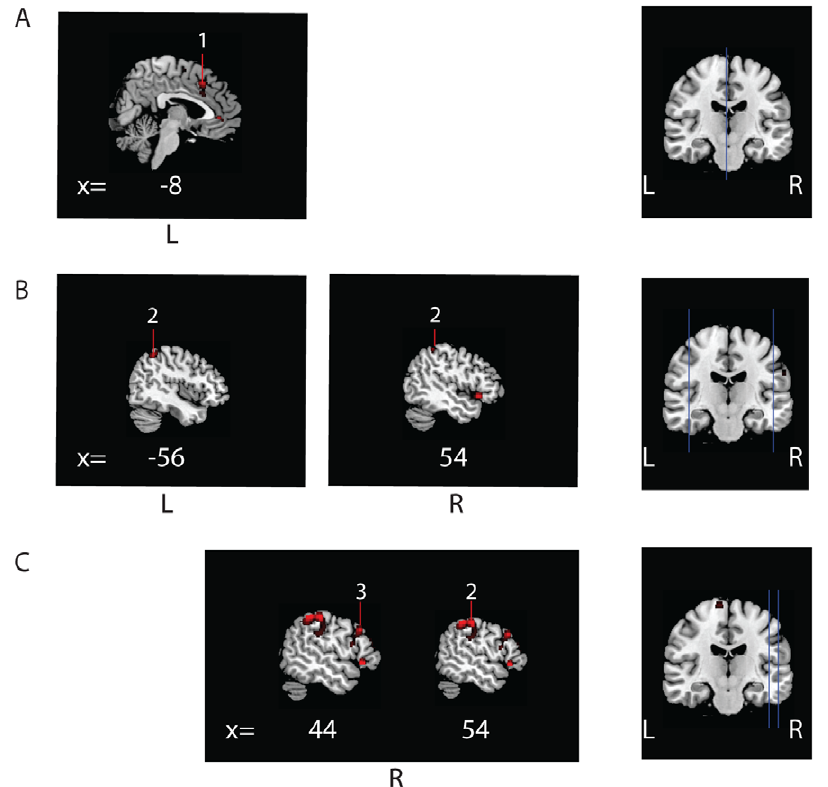
Figure 6. Significant hemisphere-specific cerebral activation patterns during movement execution in the affected hand for patients, feigners, and normal controls. Unflipped data for movement execution in the affected hand is shown for (A) patients versus normal controls, (B) feigners versus normal controls and (C) feigners versus patients. Figures were created with MRIcron, template Ch2better.nii.gz., without restriction of number of voxels. X-coordinates (in mm) for each saggital section are listed below. Numbers indicate clusters that were significant at cluster-level (P , 0.05, whole-brain corrected at cluster level; k . 200). Note that this Figure also displays activity (not numbered) significant at an uncorrected threshold, to preserve explorative qualities of the study. A: Increased activation in patients versus normal controls (red, t=3.16 to yellow, t=5). B: Increased activation in feigners versus normal controls (red, t=3.16 to yellow, t=5). C: Increased activation in feigners versus patients (red, t=3.16 to yellow, t=5). 1=medial cingulate cortex, 2=supramarginal gyrus, 3=dorso lateral prefrontal cortex. L=left,